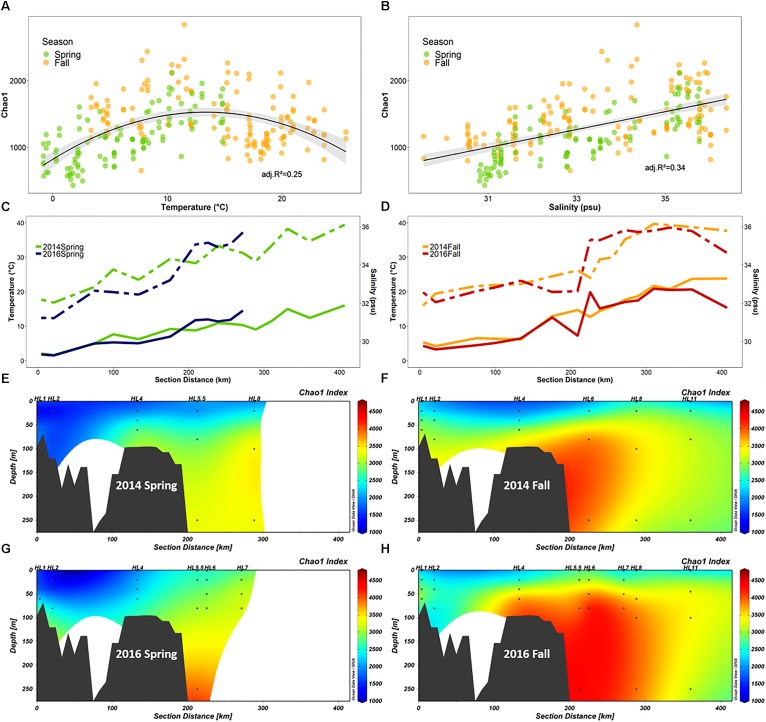
Diversity of the microbial community (FL and PA combined) along the Halifax Line (HL) section in spring and fall of 2014 and 2016 (n = 252). (A,B) Show Chao1 richness index as a function of salinity and temperature, respectively. The maximum Chao1 value was observed at 13.3°C. (C,D) Show line graphs of salinity (dashed) and temperature (solid) at 50 m depth throughout the HL transect in spring and fall, respectively. (E–H) Show the section plots of Chao1 index (summed over FL and PA samples) in both 2014 and 2016 spring (E,G, respectively) and fall (F,H, respectively) cruises. Points indicate locations of data collection; gray polygons are the bottom contour (GEBCO 2014 6 × 6 min). Stations sampled in this study are labeled above the plots.